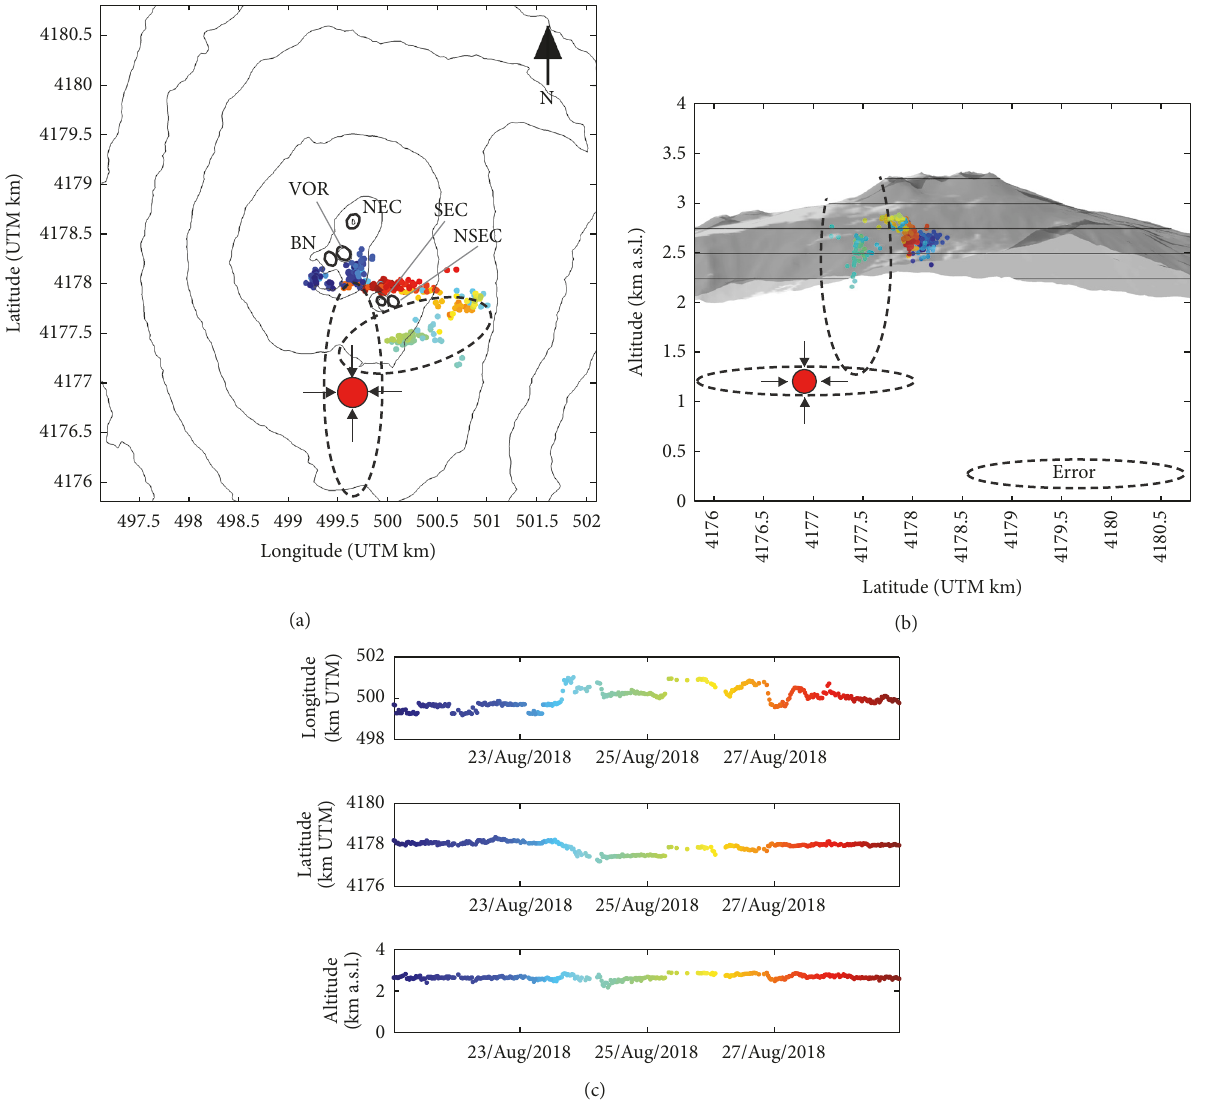
Figure 7: Map showing the locations (a) and E-W section (b) of the modeled results; errors are represented by ellipses. Volcanic tremor source coordinates and altitude variations (c). The color code is time